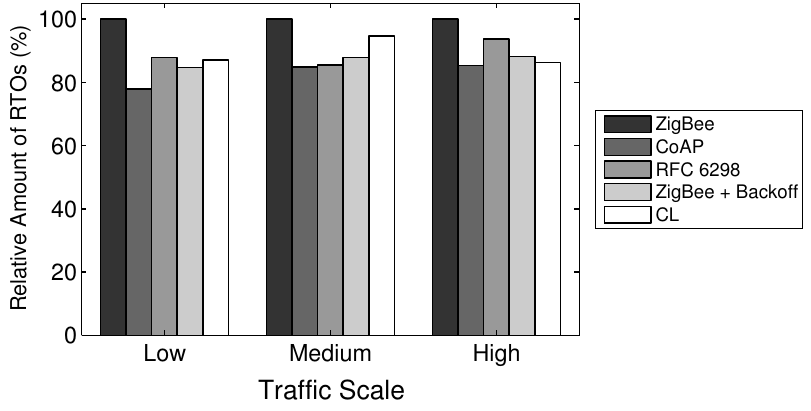
Figure 19. Relative amount of RTO expirations as seen from the application (APL) layer, when using different RTO value calculation algorithms, taking the default ZigBee RTO method as the